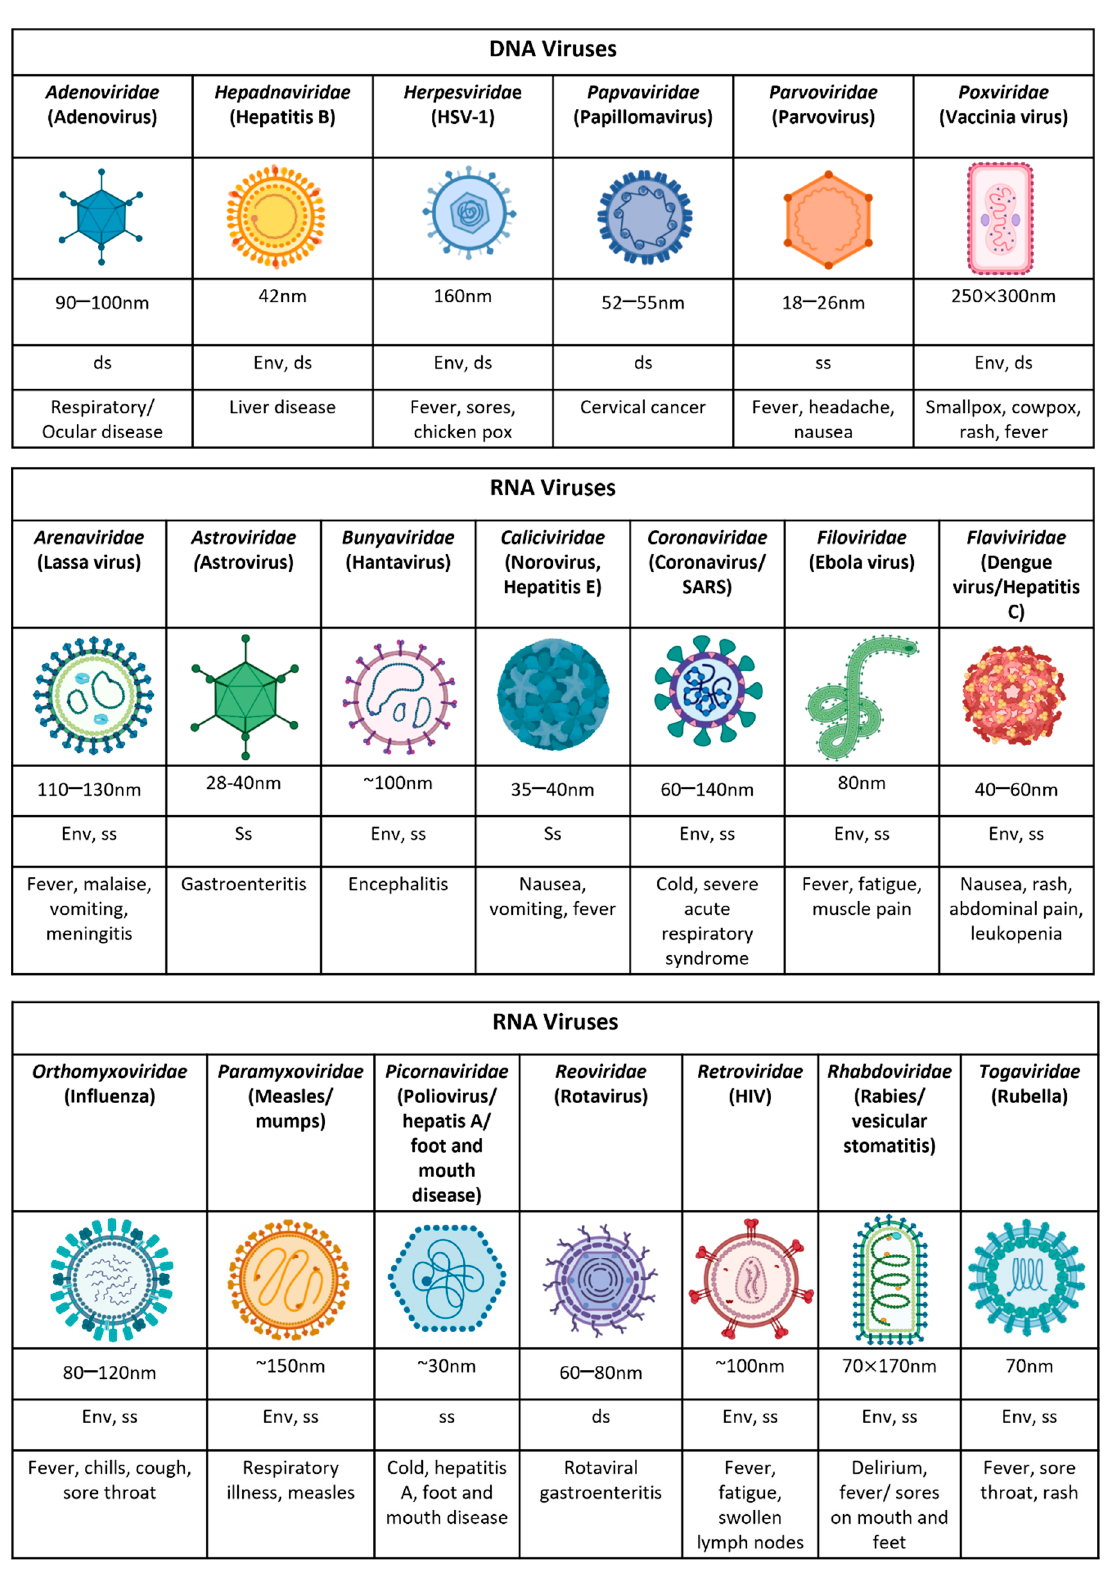
Figure 1. The characteristic features of human viruses. An overview of their typical size, genetic material, envelope, and their clinical presentation following infection. Env = enveloped, ss = single stranded, ds = double stranded.